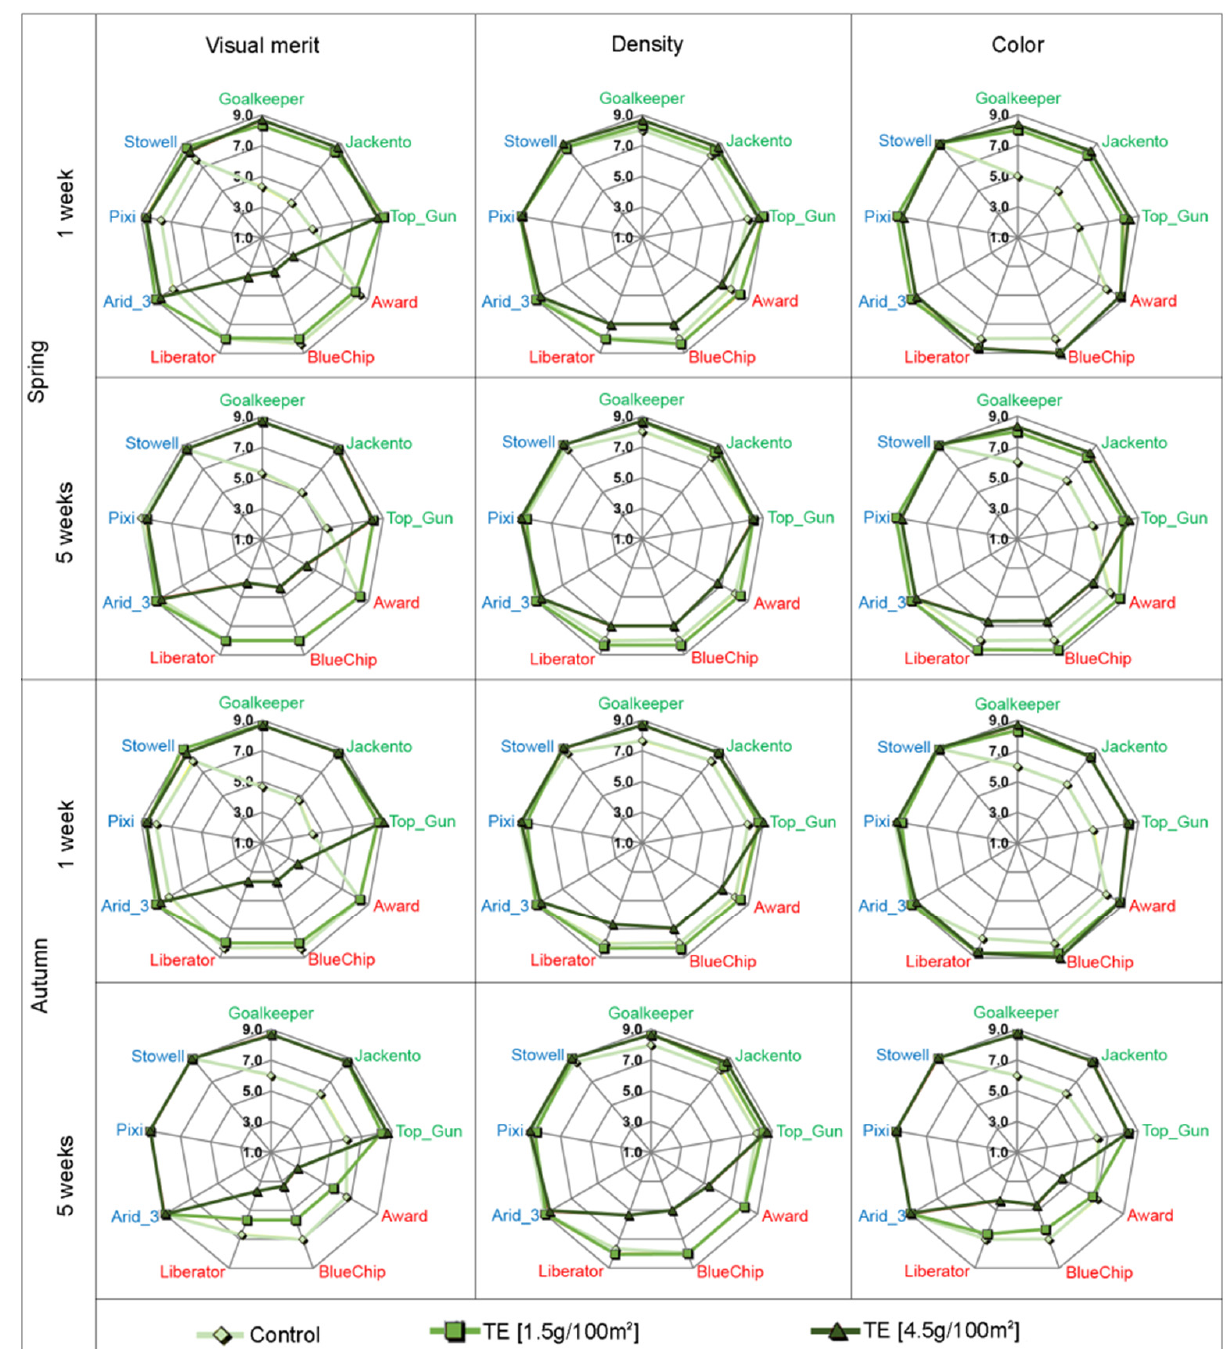
Figure 2. Radar plots for comparison of visual merit, turf density, and turf color. The statistical im- portance of differences is shown in Table S1. In addition, color code is used in inscriptions catego- rizing species: varieties names in green letters– varieties of perennial ryegrass: Goalkeeper, Jackento, Top Gun; varieties names in red letters– varieties of Kentucky bluegrass: Award, BlueChip, Libera- tor; varieties names in blue letters– varieties of tall fescue: Arid 3, Pixi and Stowell.